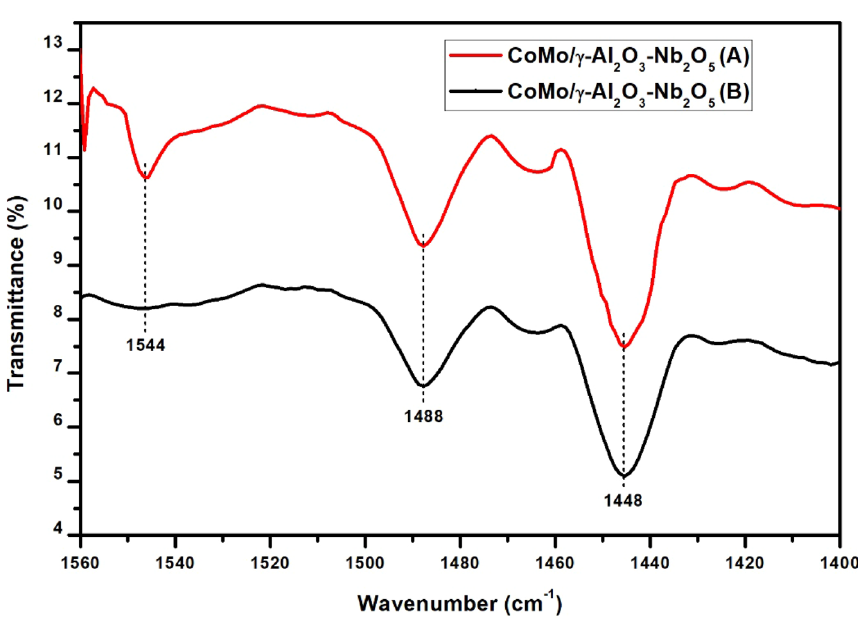
Figure 6. Pyridine IR absorption bands of CoMo/γ-Al 2 O 3 -Nb 2 O 5 catalyst before ( A ) and after ( B )